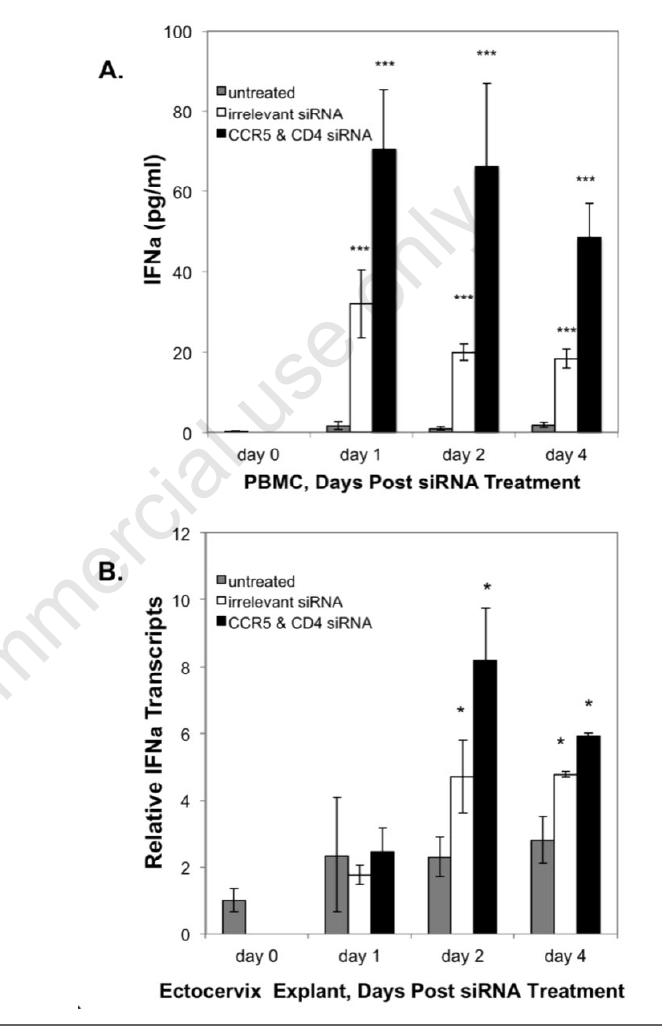
Figure 6. siRNA transfection upregulates IFN- α expression. A) IFN- α secreted by PBMC left untreated (grey bars) or treated with nanoparticles containing irrelevant siRNA (20 nM, white bars) or the combination of CCR5 & CD4-specific siRNA (10 nM each, black bars) were quantified at time 0, day 1, day 2, and day 4 post-transfection. Error bars show the standard deviation of the replicates. Asterisks (***) denote statistically signifi- cant differences (P<0.001) in IFN- α production between untreated and siRNA-treated PBMCs. B) siRNA stimulates IFN- α transcription in ectocervical explants. Total RNA was extracted from ECX explants on days 1, 2 and 4 either left untreated (grey bars), or after transfection with nanoparticles containing irrelevant siRNA (20 nM, white bars), or CCR5 plus CD4 specific siRNA (10 nM each, black bars). Levels are expressed as mean IFN- α transcripts relative to that observed at culture initiation (day 0). Error bars the show standard deviation of the means. Asterisks (*) denote statistically significant differences (P<0.05) between explants treated with siRNA as compared to untreated explants. Bars with no asterisk did not reach statistical significance at the 95% confi- dence